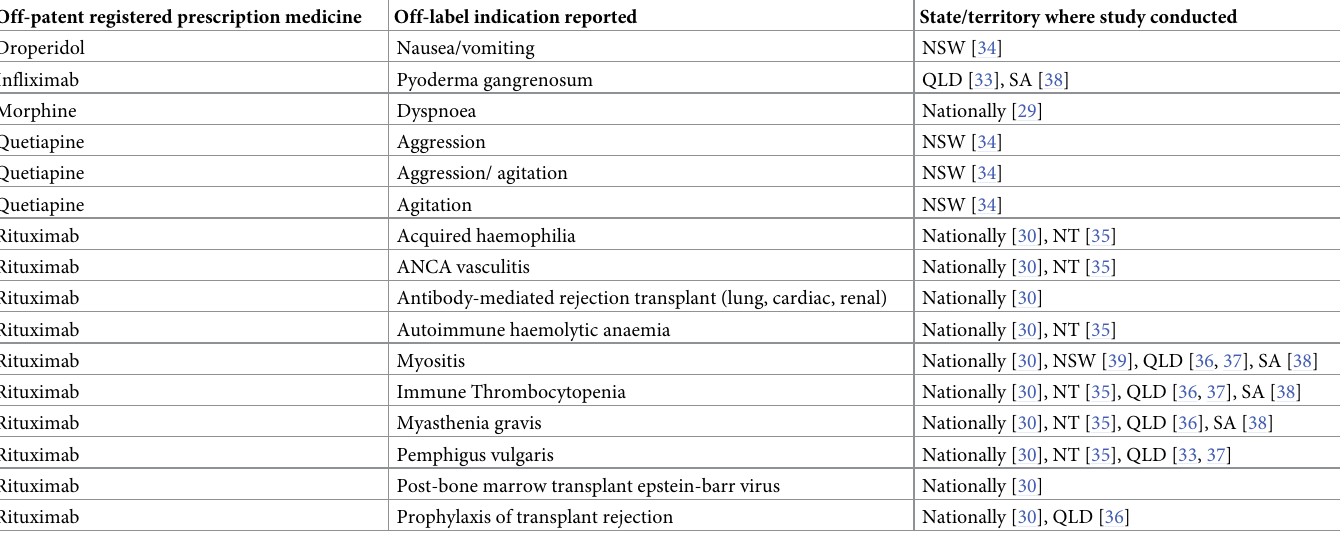
Table 7. Medication/off-label indication dyads only found on SAMF and in the